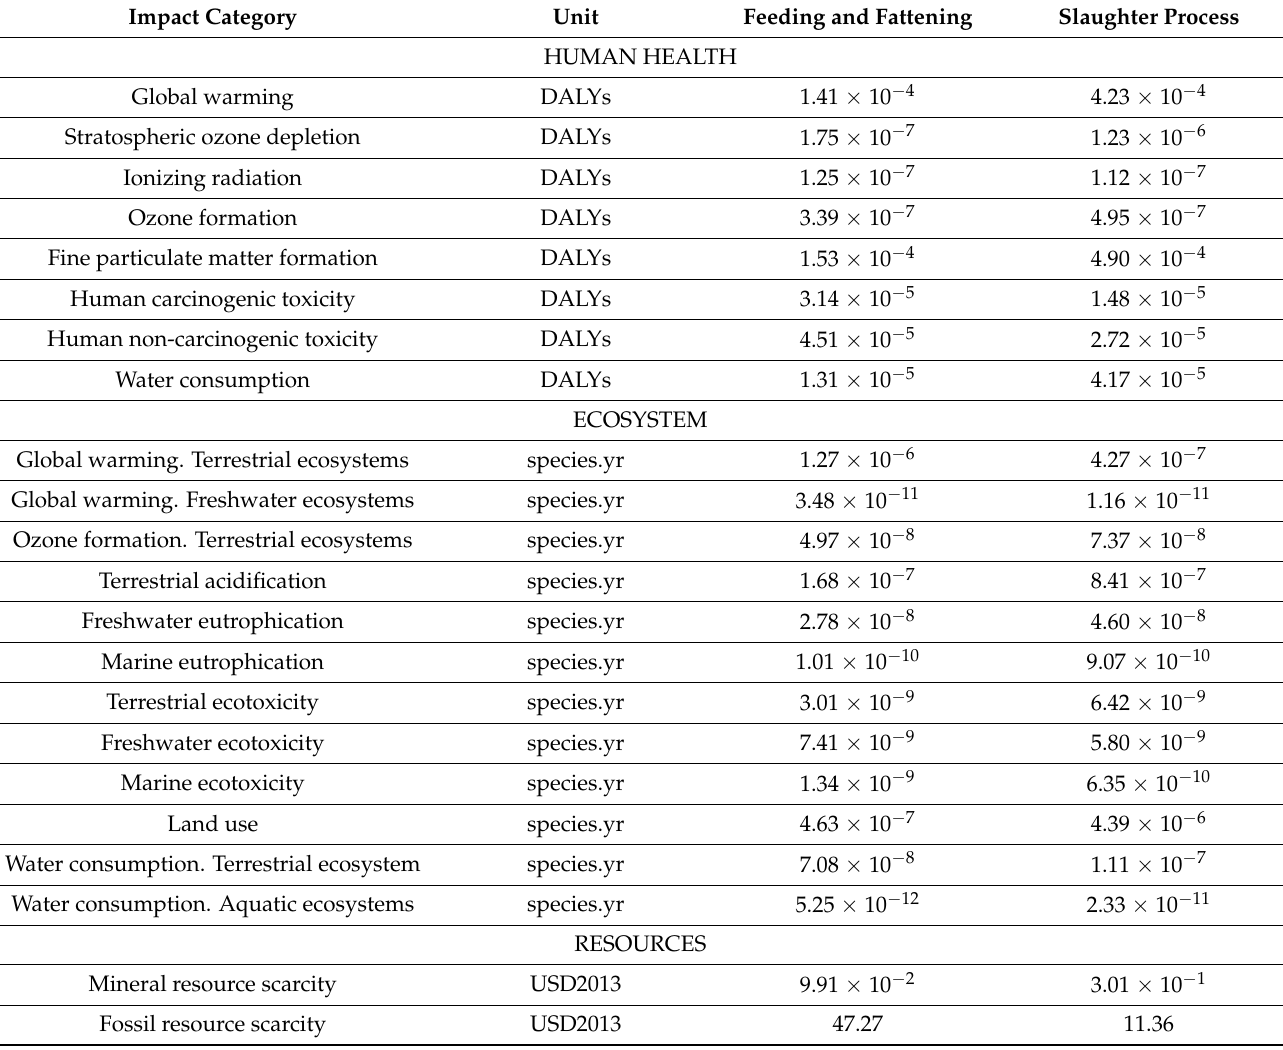
Table 4. LCIA for pork